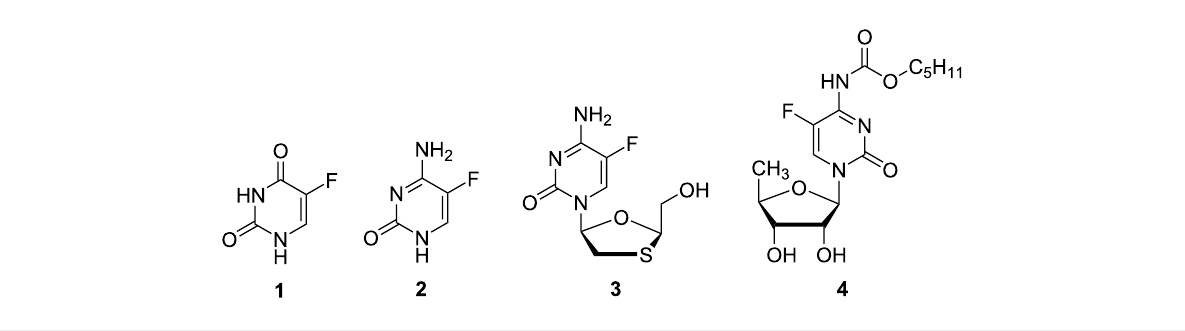
Figure 1: The structures of 5-fluorouracil ( 1 ), 5-fluorocytosine ( 2 ), emtricitabine ( 3 ) and capecitabine ( 4 ).